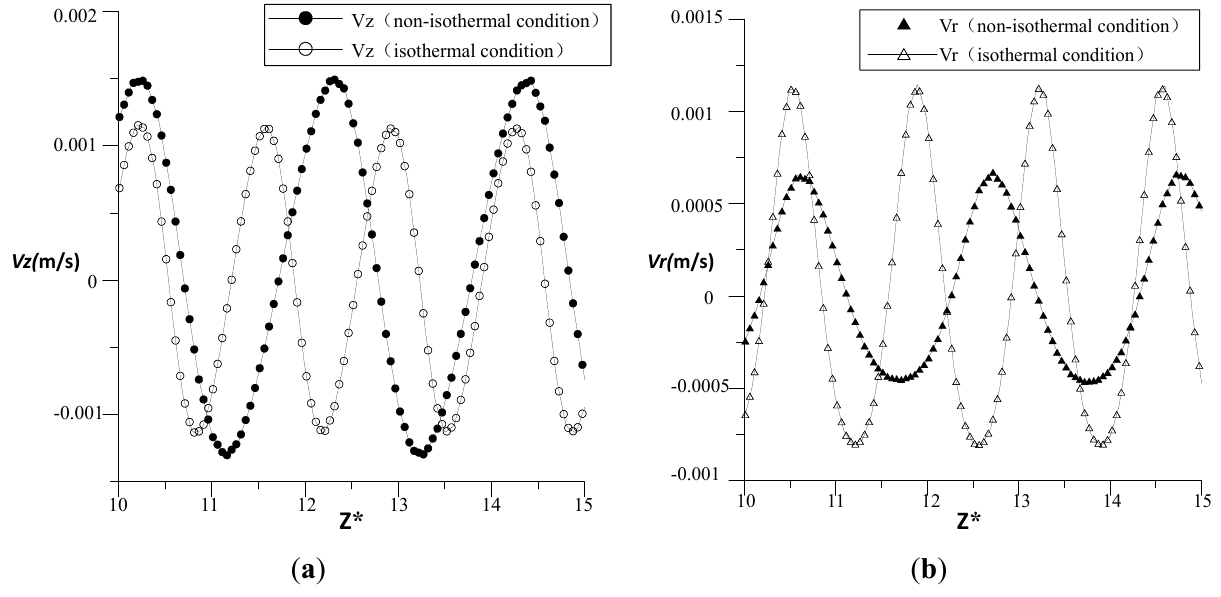
Figure 16. Axial and radial velocity profile in 6-slit model at R * = 0.2: ( a ) Axial velocity; and ( b ) Radial